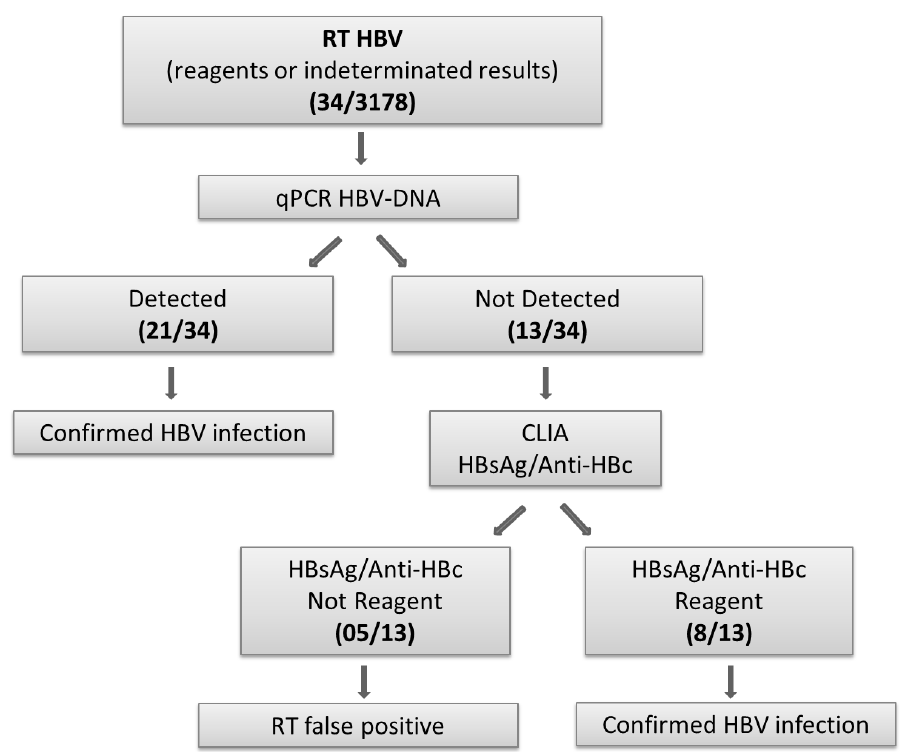
Figure 1. Algorithm to confirm results from participants who tested positive for HBsAg by rapid diagnostic test. HBV: hepatitis B virus; RT: rapid diagnostic test; qPCR: real-time PCR; CLIA: chem- iluminescence; HBsAg: hepatitis B surface antigen; Anti-HBc: hepatitis B core